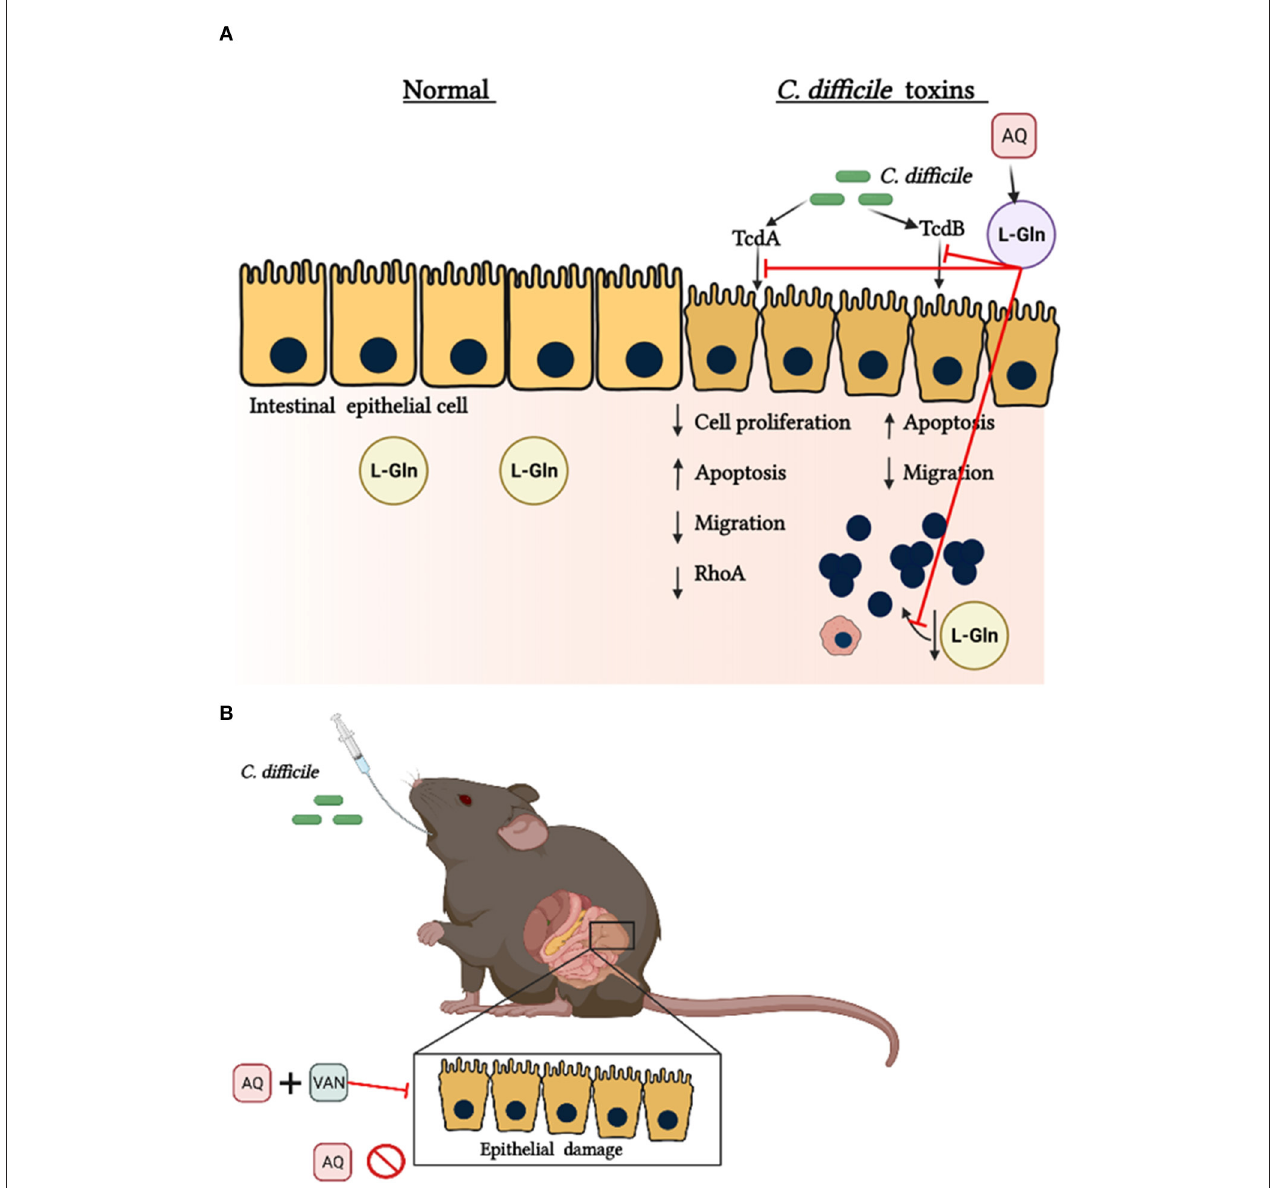
FIGURE 5 | Protective effects of glutamine during C. difficile toxins Challenge. (A) In normal conditions endogenous glutamine (L-Gln) maintains epithelial functions. C. difficile toxin A (TcdA) and C. difficile toxin B (TcdB) promote a decrease in intestinal epithelial cell proliferation, migration and RhoA levels. C. difficile toxins also decrease the levels of L-Gln into the intestine. Alanyl-glutamine (AQ), as a source of L-Gln, inhibits these toxins’ effects. (B) AQ decreases the intestinal epithelial damage during CDI only if infected mice receive vancomycin